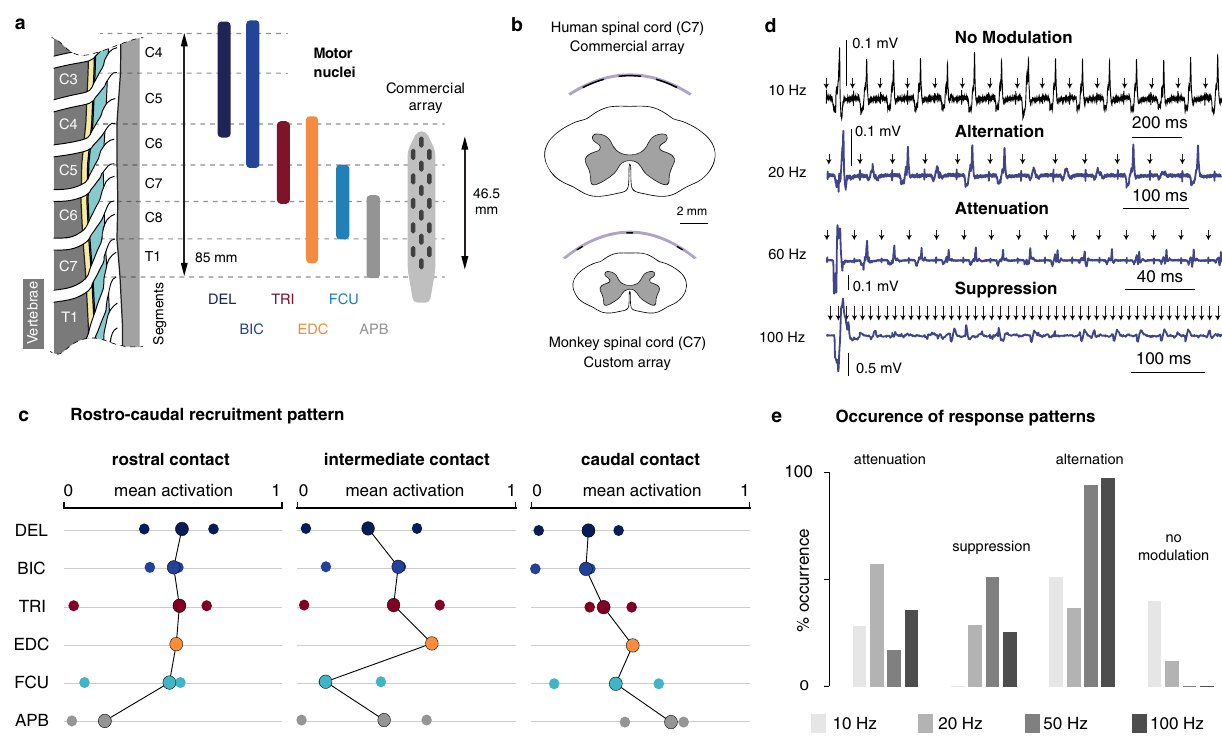
Fig. 9 Muscular activity patterns evoked by EES of the cervical spinal cord in humans. a Dimensions of the human cervical spinal segments, heuristic distribution of the motor nuclei of 6 upper-limb muscles 28 , and sketch of the commercial paddle epidural electrode array used in 3 human patients. DEL: deltoid, BIC: biceps, TRI: triceps, EDC: extensor digitorum communis, FCU: fl exor carpi ulnaris, APB: abductor pollicis brevis. b Comparison between the relative dimensions of the monkey cervical spinal cord and our custom implant, and the human cervical spinal cord and the commercial epidural implant of ( a ). c Mean muscular activations observed in 5 patients. One rostral, one caudal and one intermediate sites of stimulation (all lateral) were chosen for each patient, and the observed mean muscular activations (see “ Methods ” ) reported as individual bullets. For EDC, only 2 patients available. For FCU: only 3. Circled connected bullets: medians across the patients. d Examples of frequency-dependent modulation of muscular responses. The 4 EMG traces were obtained in the same muscle, using the same stimulation amplitude (near motor threshold) but different frequencies. Arrows: timestamps of stimulation pulses. e Frequency of occurrence of muscular response patterns during high-frequency stimulation. All the patterns recorded in all the muscles of the 3 subjects were included in the analysis ( n = 24 patterns at 10 Hz, n = 32 patterns at 20 Hz, n = 32 patterns at 60 Hz, n = 24 patterns at 100